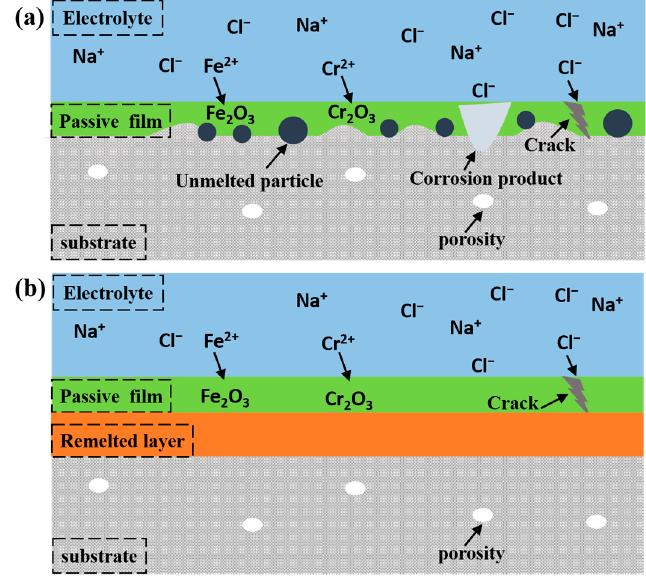
Figure 12. Corrosion mechanism diagram of the ( a ) original and ( b ) laser-polished 316L stainless steel.